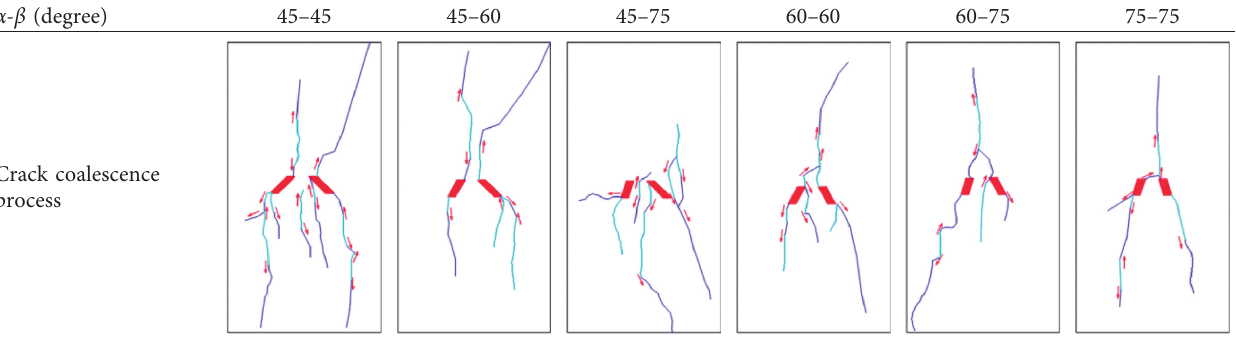
Table 4: Sketch of macro crack coalescence process in the specimens containing two parallelogram flaws with different angles under uniaxial compression (the light-blue lines represent the initial cracks and the dark-blue lines represent the new cracks emanating from the initial cracks).